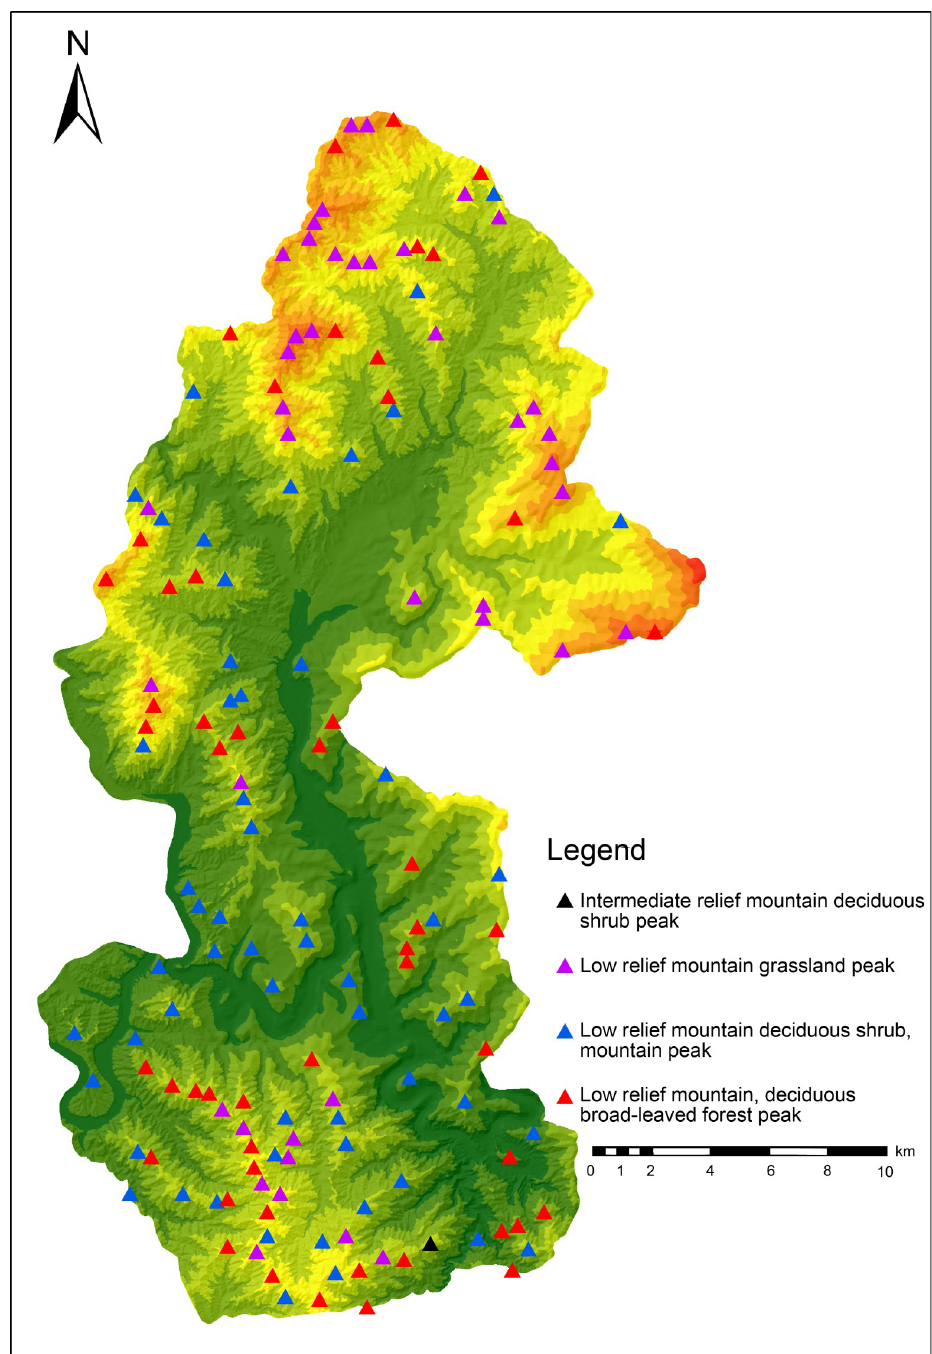
Fig 6. Distribution map of peaks in mountainous area of the Yesanpo National Park. (Republished from [https:// directory.eoportal.org/web/eoportal/satellite-missions/g/gaofen-2] under a CC BY license, with permission